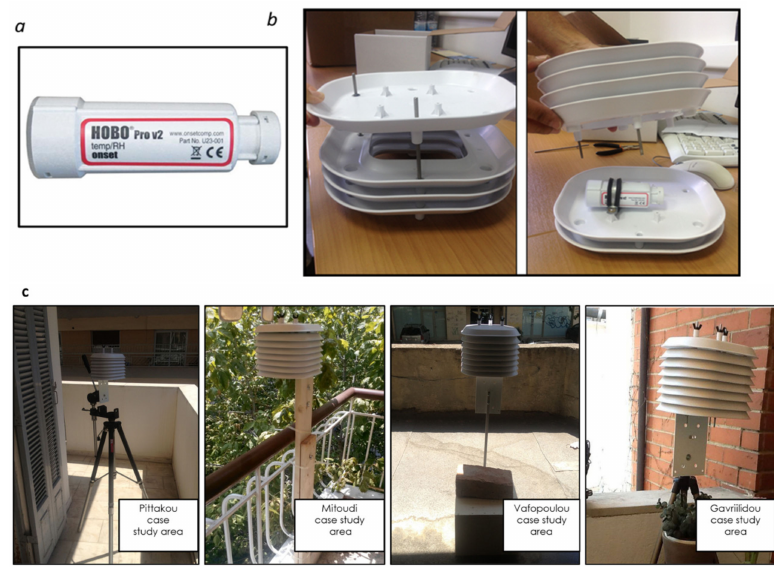
Figure 4. ( a ) Weatherproof HOBO data loggers suitable for the outdoor environment, ( b ) radiation shields in which the loggers were placed and ( c ) mounting of the radiation shields at each one of the four study areas.